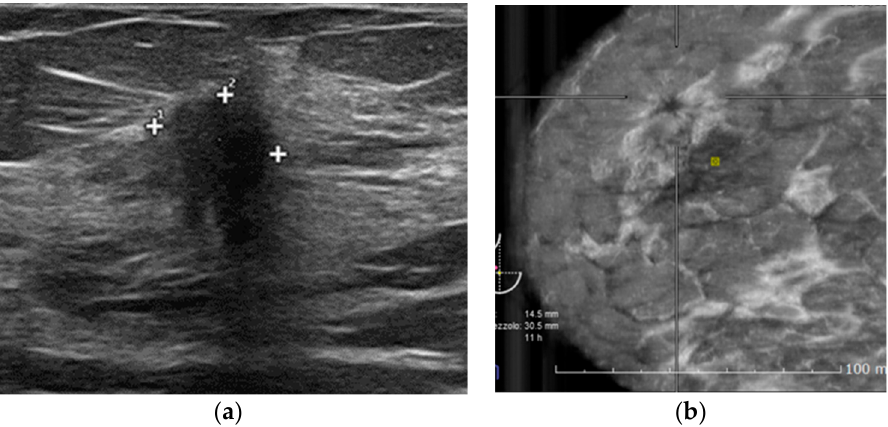
Figure 3. 49-year-old woman with no family history of breast cancer performs her annual control. Both HHUS and ABVS identified breast cancer. ( a ) HHUS shows a mass with indistinct margins biopsy-proven invasive ductal carcinoma in the lower outer quadrant of the right breast. ( b ) Retraction phenomenon in ABVS coronal view.